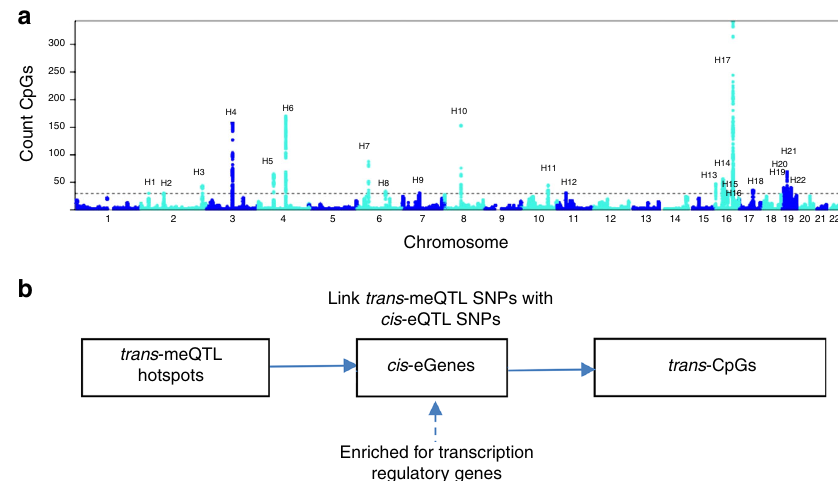
Fig. 7 Overview and characteristics of trans- meQTLs. a trans- meQTL hotspots; b Linking trans- meQTLs with cis-